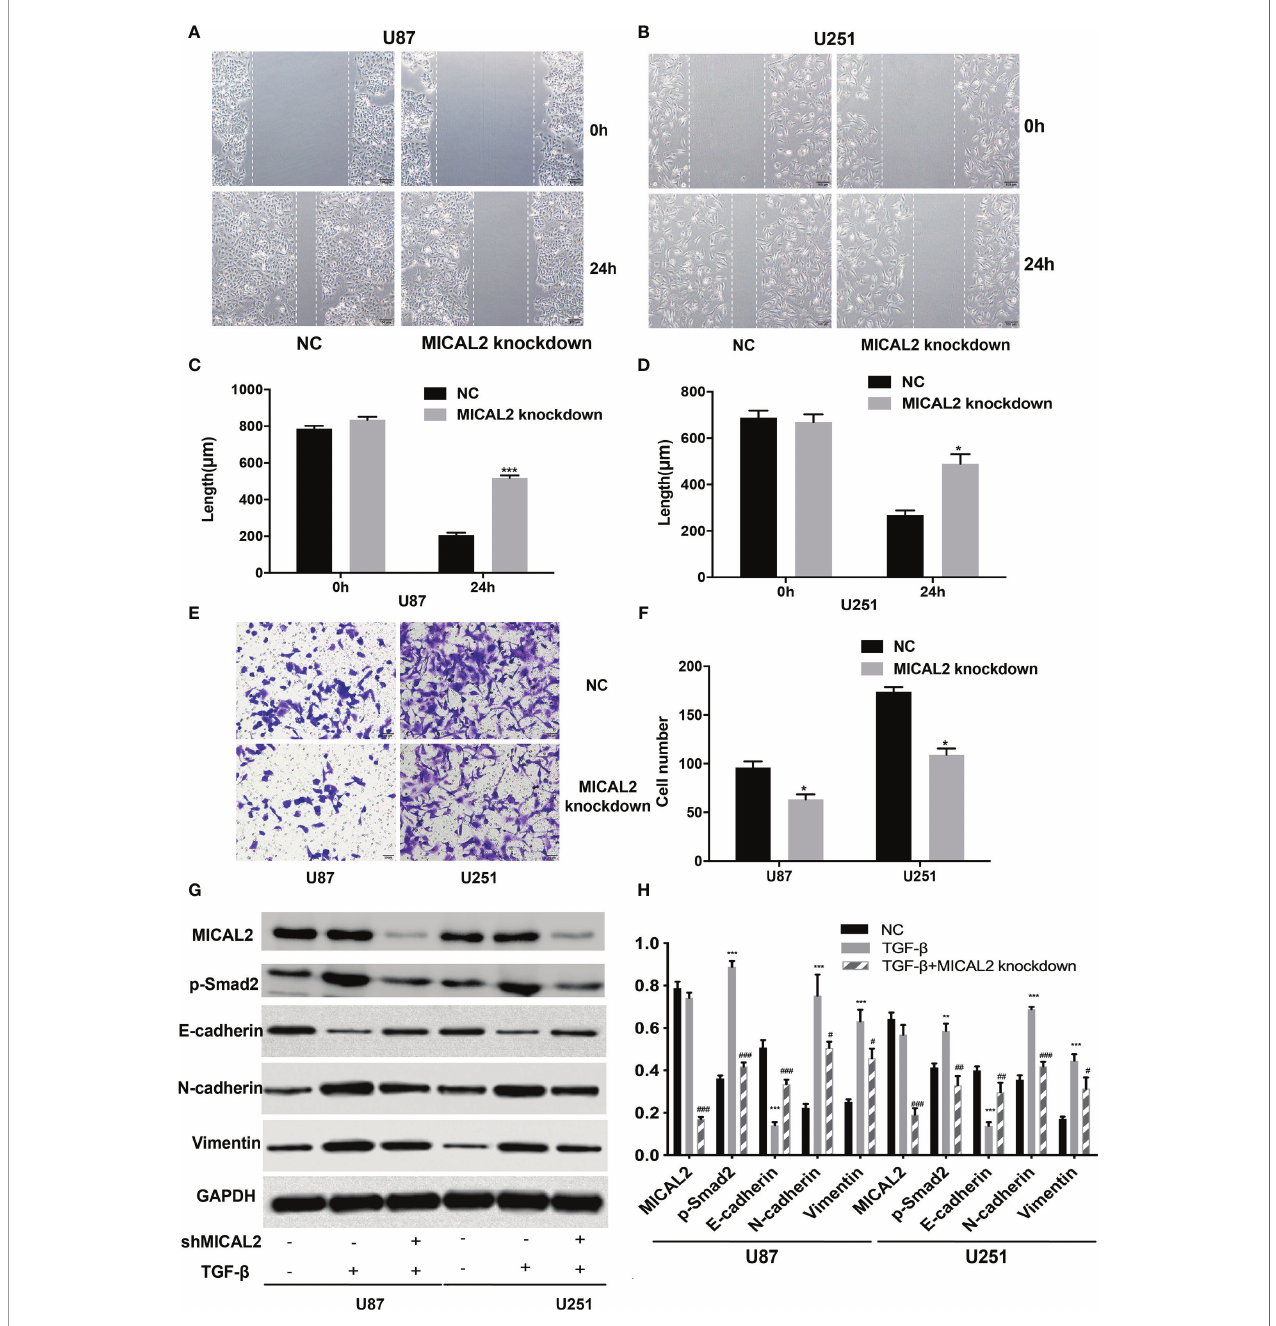
FIGURE 4 | Downregulation of TGFRI supressess migration and invasion of glioma cells. (A – D) The effect of TGFRI on cell migration was determined via wound-healing assay. Comparing with the NC group, the length of wound in TGFRI knockdown group in U87 ( p < 0.001) and U251 ( p < 0.05) were signi fi cantly higher after 24 h of healing. (E , F) Transwell migration assay was used to detect cell invasion ability of GBM cells. Cell number of TGFRI knockdown group were decreased in U87 ( p < 0.05) and U251 ( p < 0.05) cell lines compared with the NC group. (G , H) TGFRI, p-Smad2, and EMT relative protein (E-cadherin, N-cadherin, and vimentin) expression were detected via Western blotting. Data are shown as the means ± SEM of three experiments.Asterisk represents TGF- b -induced group comparing with the NC group; number sign represents TGF- b -induced and TGFRI-knockdown group comparing with the TGF- b -induced group; *, # p < 0.05, **, ## p < 0.01, ***, ### p <